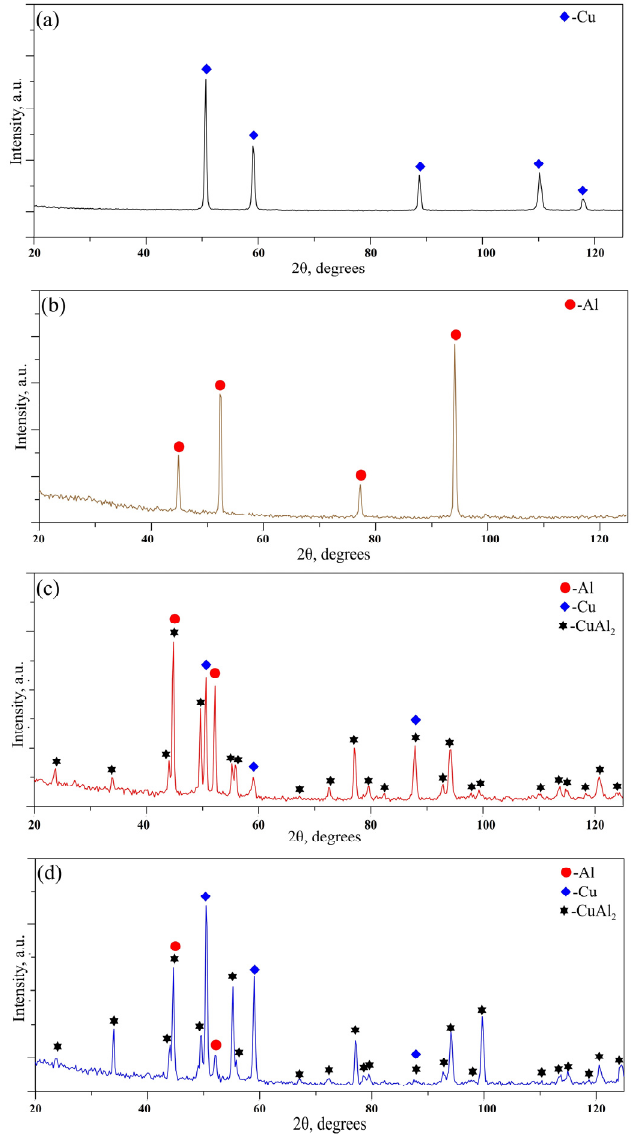
Figure 2. X-ray diffraction patterns of: ( a ) pure copper; ( b ) Al6082T6; ( c ) weld seam with an oscillation radius of 0.1 mm; and ( d ) weld seam with an oscillation radius of 0.2 mm. The results exhibit the diffraction maxima of pure Al , pure Cu , and the intermetallic CuAl 2 phases. The CuAl 2 intermetallic compound , also known as the θ phase , is charac- terized by a body-centered tetragonal structure. Aluminum and copper both have their circle radius does not affect the phase composition of the formed weld with respect to the number of detected diffraction